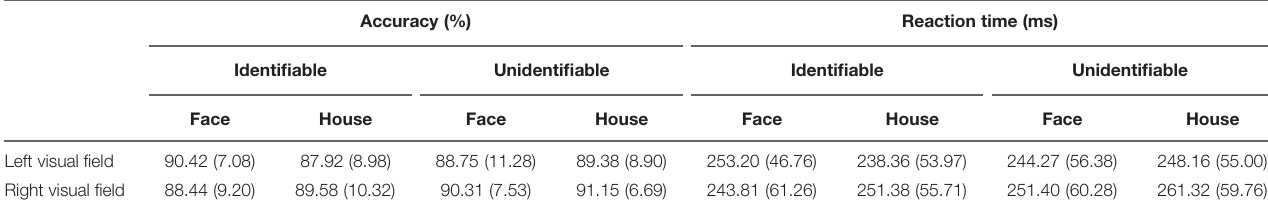
TABLE 1 | Behavioral results [Mean